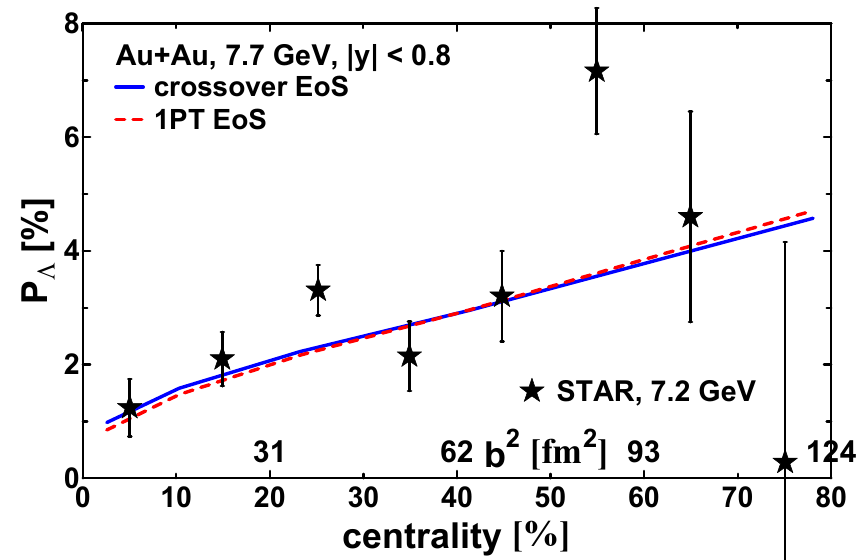
Figure 3. Centrality dependence of the global Λ polarization in the midrapidity region ( | y h | < 0.8) in √ s NN = 7.7 GeV. The results for different EoSs are presented. Preliminary STAR Au+Au collisions at √ s NN = 7.2 GeV are from Ref. [36]; only statistical errors are data for Au+Au collisions at